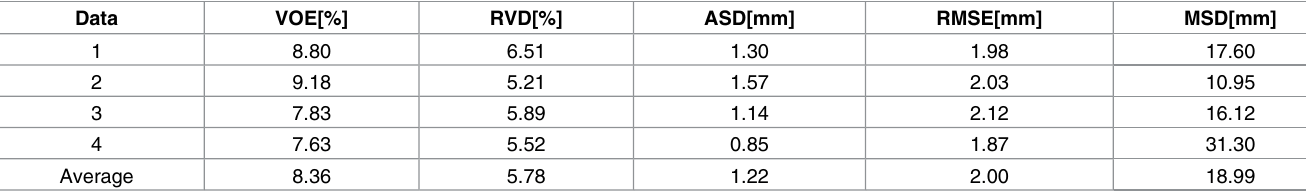
Fig 11. The surfacedistance error for different voxels in each data: (a) Data 1; (b) Data 2; (c) Data 3; (d) Data 4. doi:10.1371/journal.pone.0164098.g011 Table 2. Quantitative evaluation of MICCAI 2007 grand challenge database.